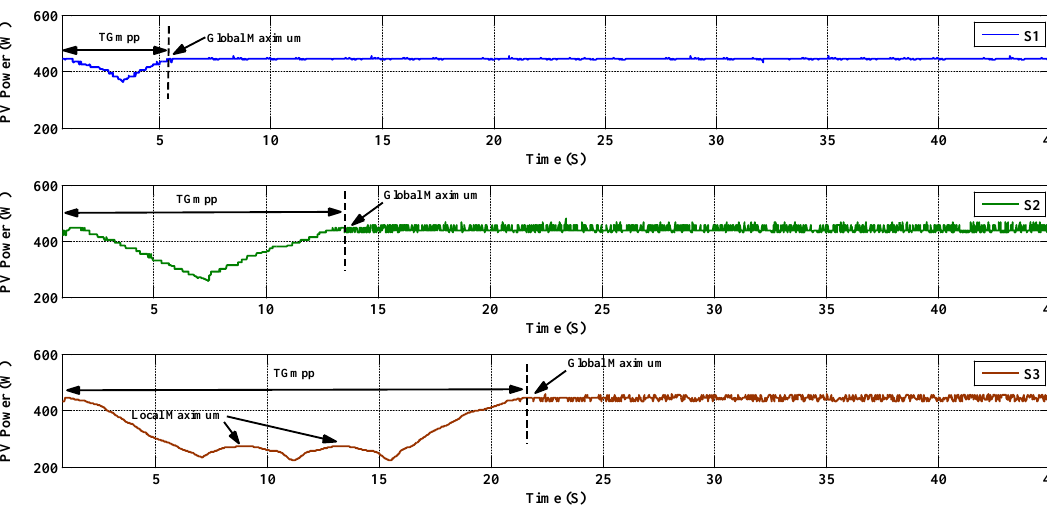
Figure 23. PV output power for the scenario of Figure